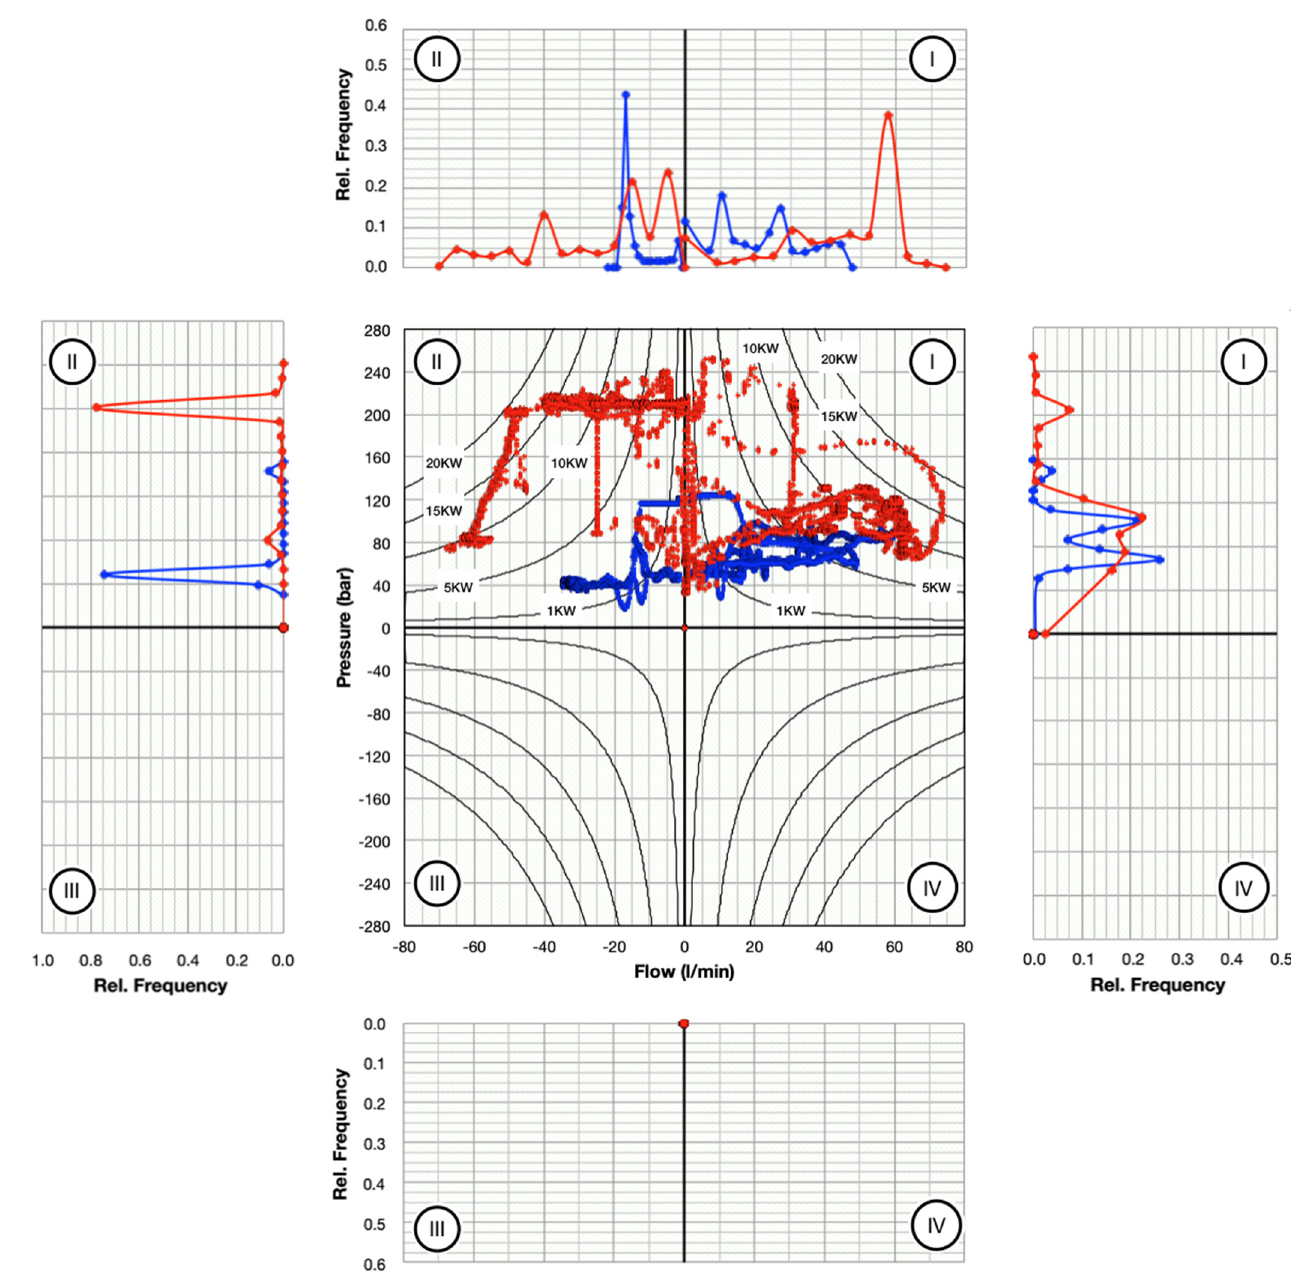
Figure 19 summarises the information for analysing the lift actuator. The middle chart shows the pairs of effective pressures and flow rates for the pump (red) and the actuator (blue), including constant power hyperbolas to quantify the power of any operation point. The right and left charts show on the same scale the relative frequencies of the pressures and the bottom and top charts show the relative frequencies of the flows rates.